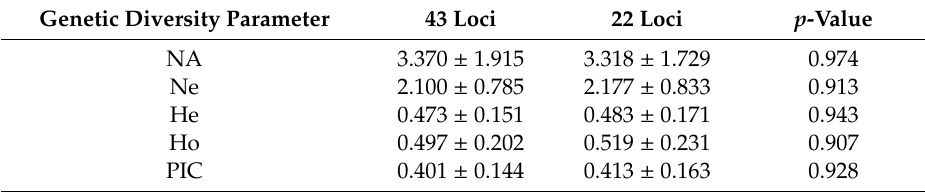
Table 2. Genetic diversity analysis of F0 generation of New Zealand white rabbits with two SSR marker